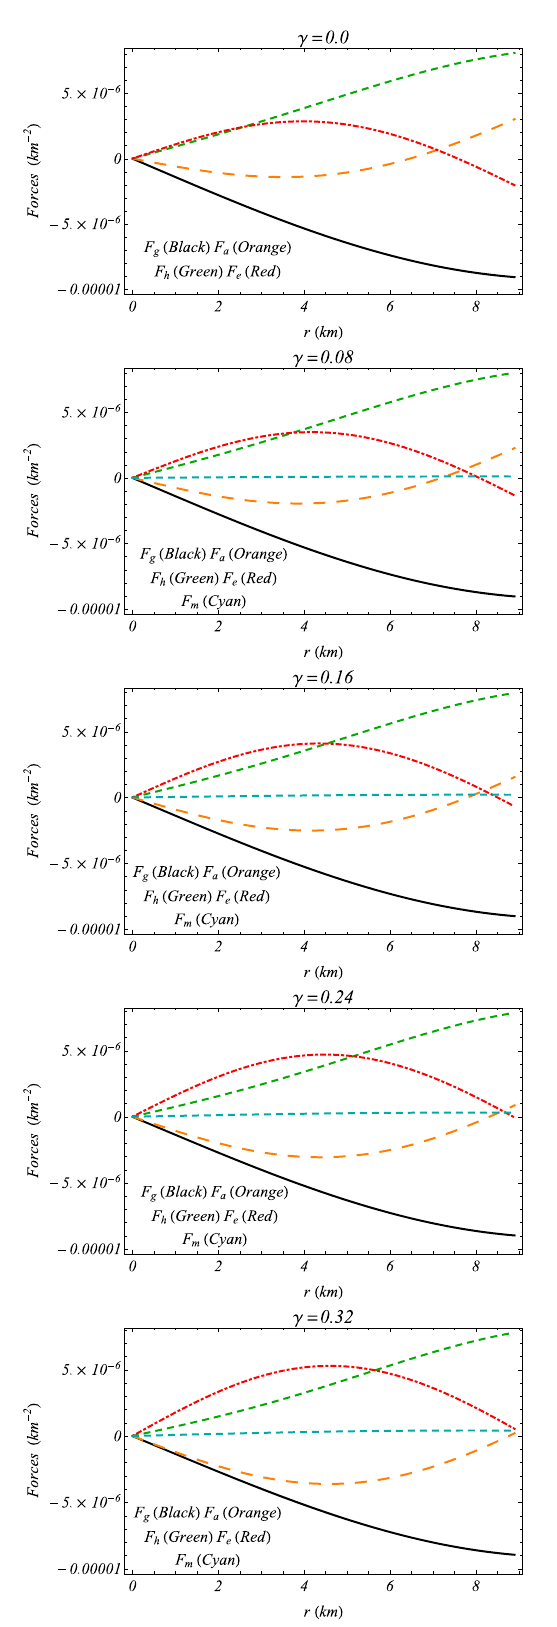
Fig. 9 Different forces acting on the present model against r for the strange star candidate SAX J1808.4-3658 by taking different values of γ